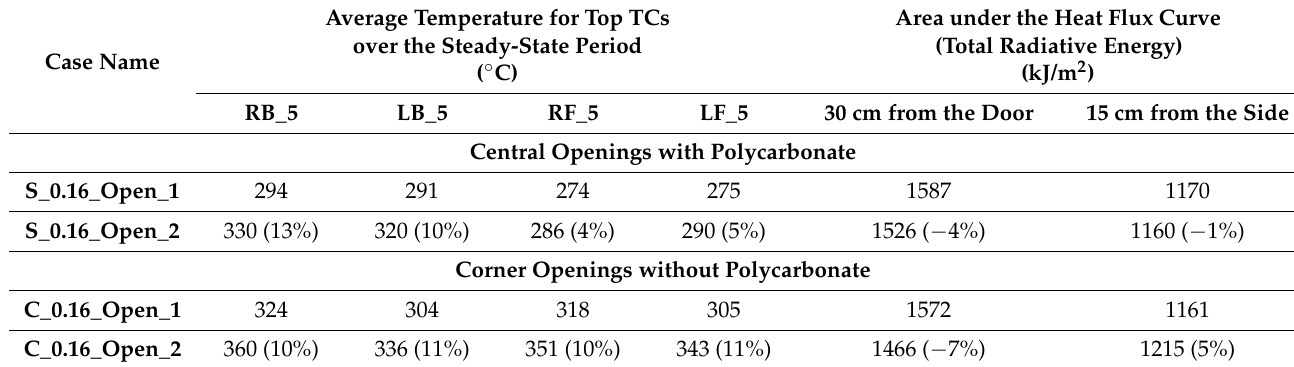
Table 2. Repeatability check for two